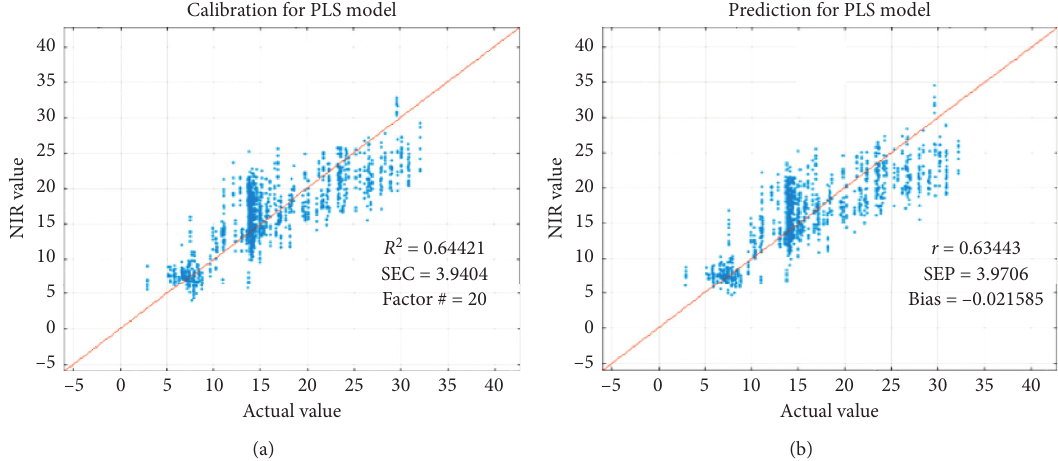
Figure 6: Measured vs. VIS/NIR values of α -chaconine (mg kg − 1 ) in the calibration (a) and prediction (b) sets with PLS